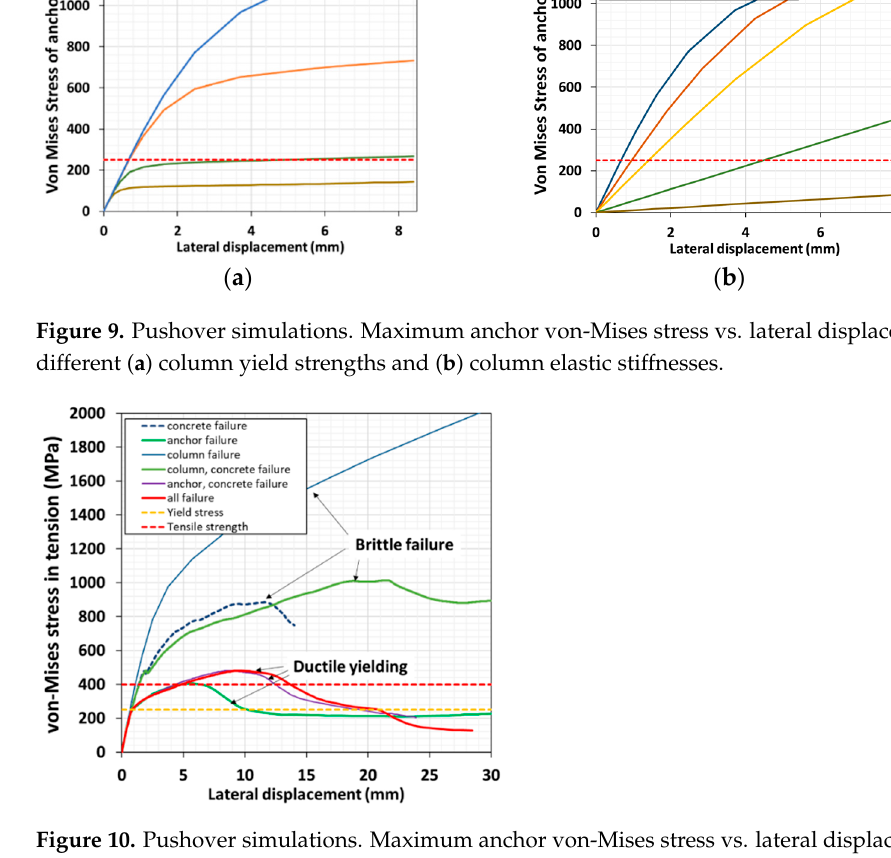
Figure 9. Pushover simulations. Maximum anchor von-Mises stress vs. lateral displacement under different ( a ) column yield strengths and ( b ) column elastic stiffnesses.